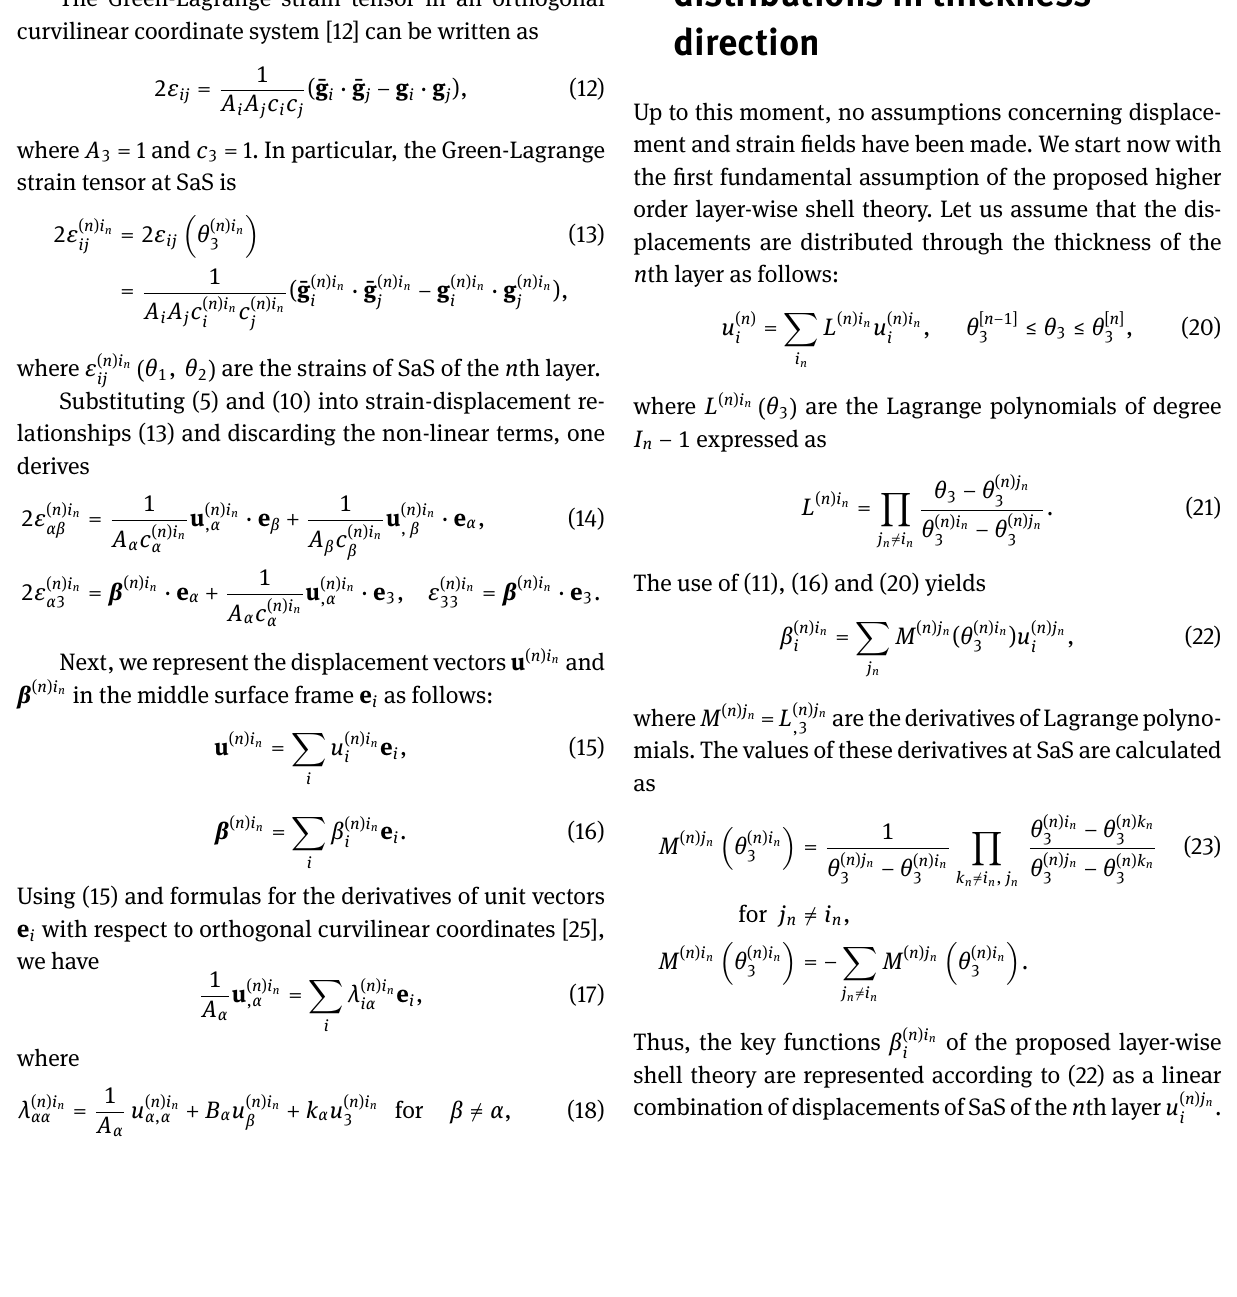
Figure 2: Initial and current configurations of the shell. The Green-Lagrange strain tensor in an